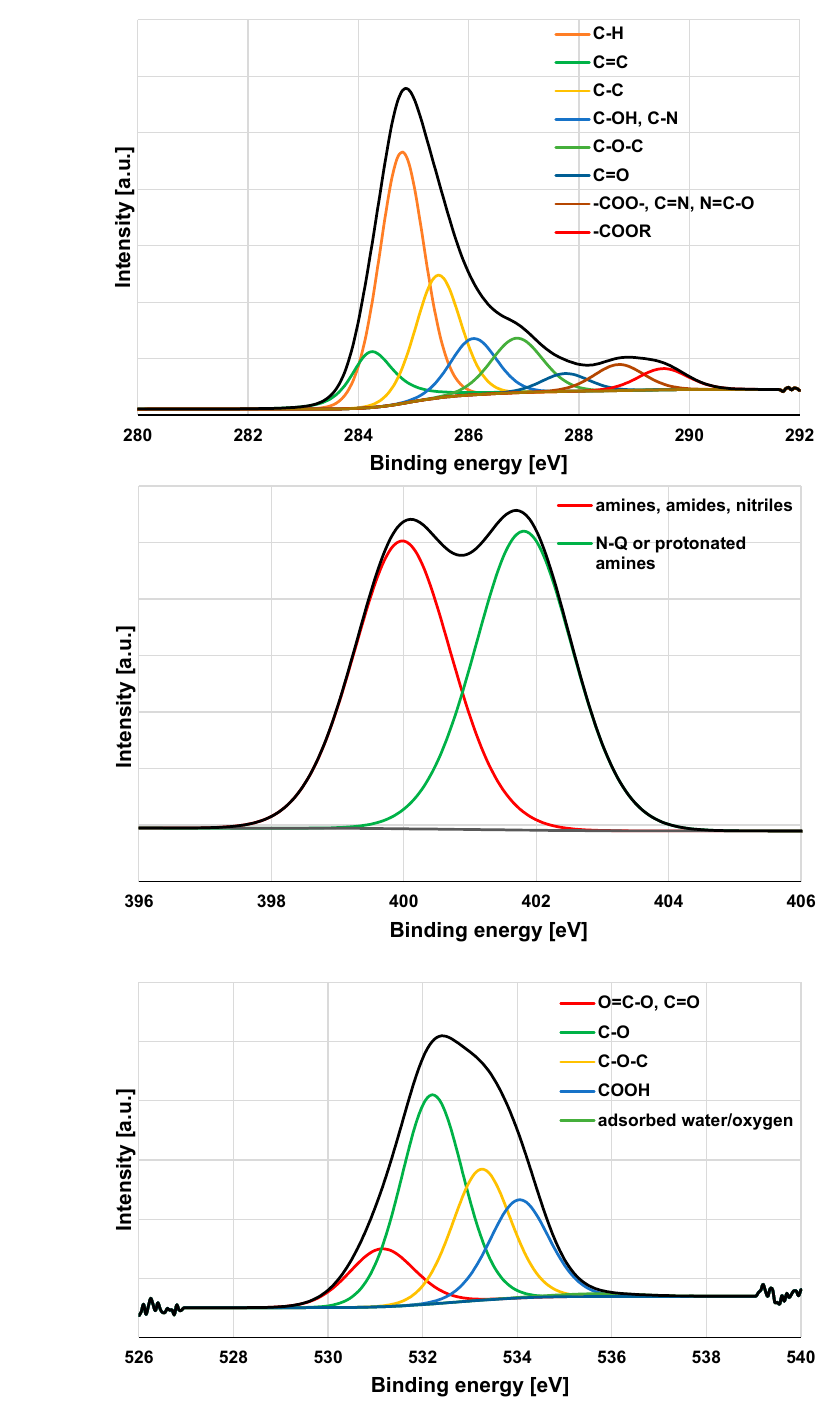
Figure 10. C 1s ( a ), N 1s ( b ) and O 1s ( c ) spectra of NE–AC activated carbon after PAA and PEI simultaneous adsorption.